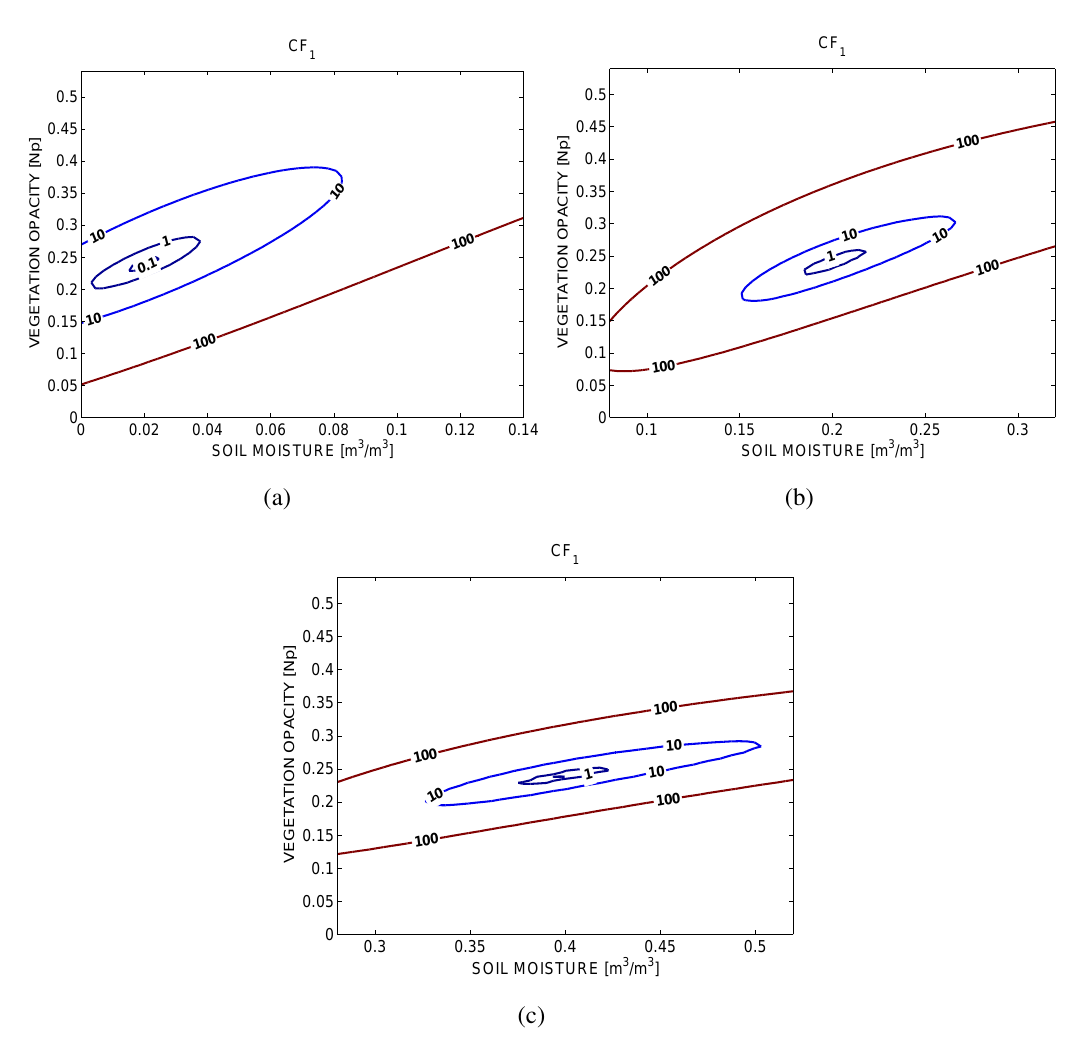
Figure 5. Cost functions formulated using T Contours of (cid:28) vs. s (a) over a vegetation-covered dry scenario. Contours m of (cid:28) vs. s (b) over a vegetation-covered moist scenario. Contours of (cid:28) vs. s m (c) over a vegetation-covered wet